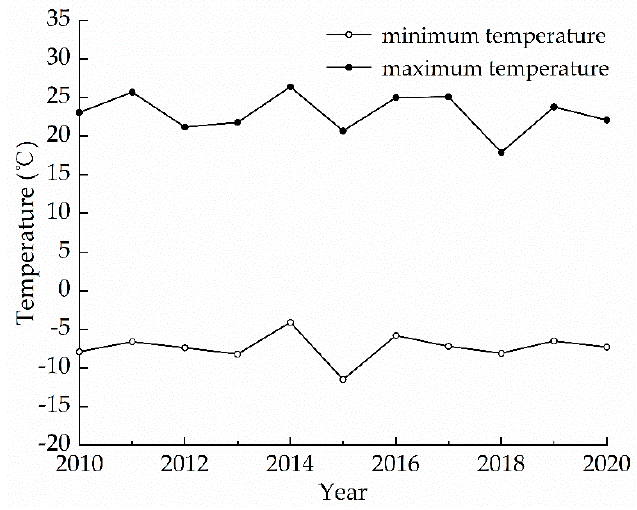
Figure 1. The minimum and maximum temperatures in winter in Kaifeng from 2010 to 2020.